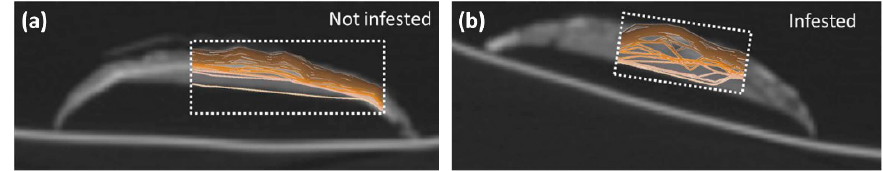
Figure 28. THz scans overlaid on CT images, revealing beetle damage. a) Healthy wood; b) infested wood. Reprinted with permission from [202] © The Optical Society.